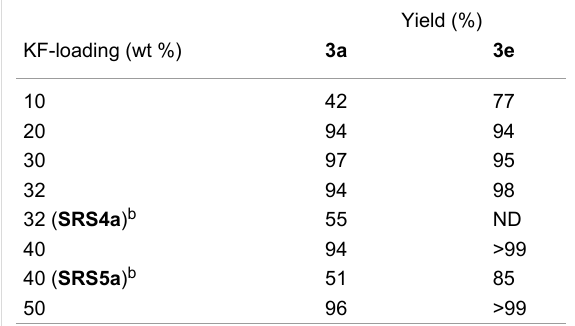
Table 4: Effect of KF concentration in case of SRS1a on the yield of the Suzuki–Miyaura reaction a of phenylboronic acid ( 1 ) with p -bromo- acetophenone ( 2a ) and with bromobenzene ( 2e ; Scheme